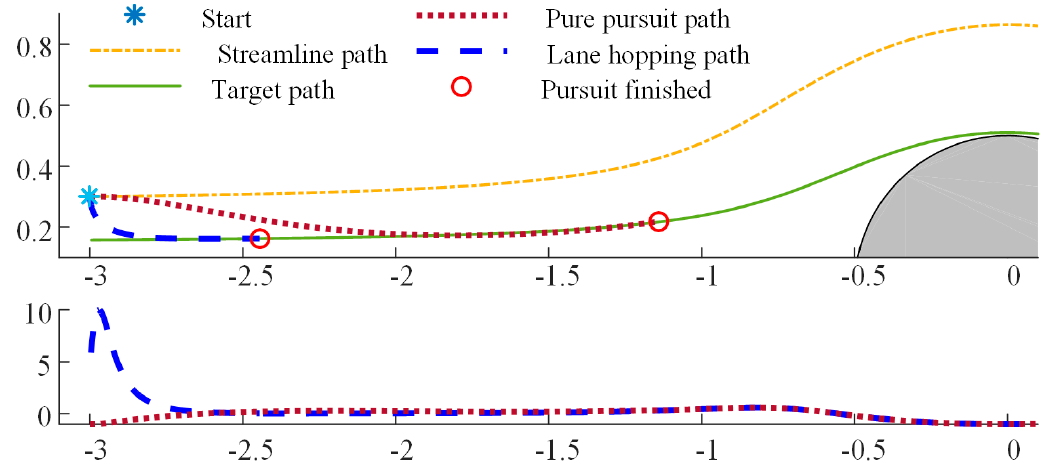
Figure 15. The comparison of pure pursuit and lane hopping: path (upper plot) and curvature (lower plot). Horizontal axis is the forward +x direction.